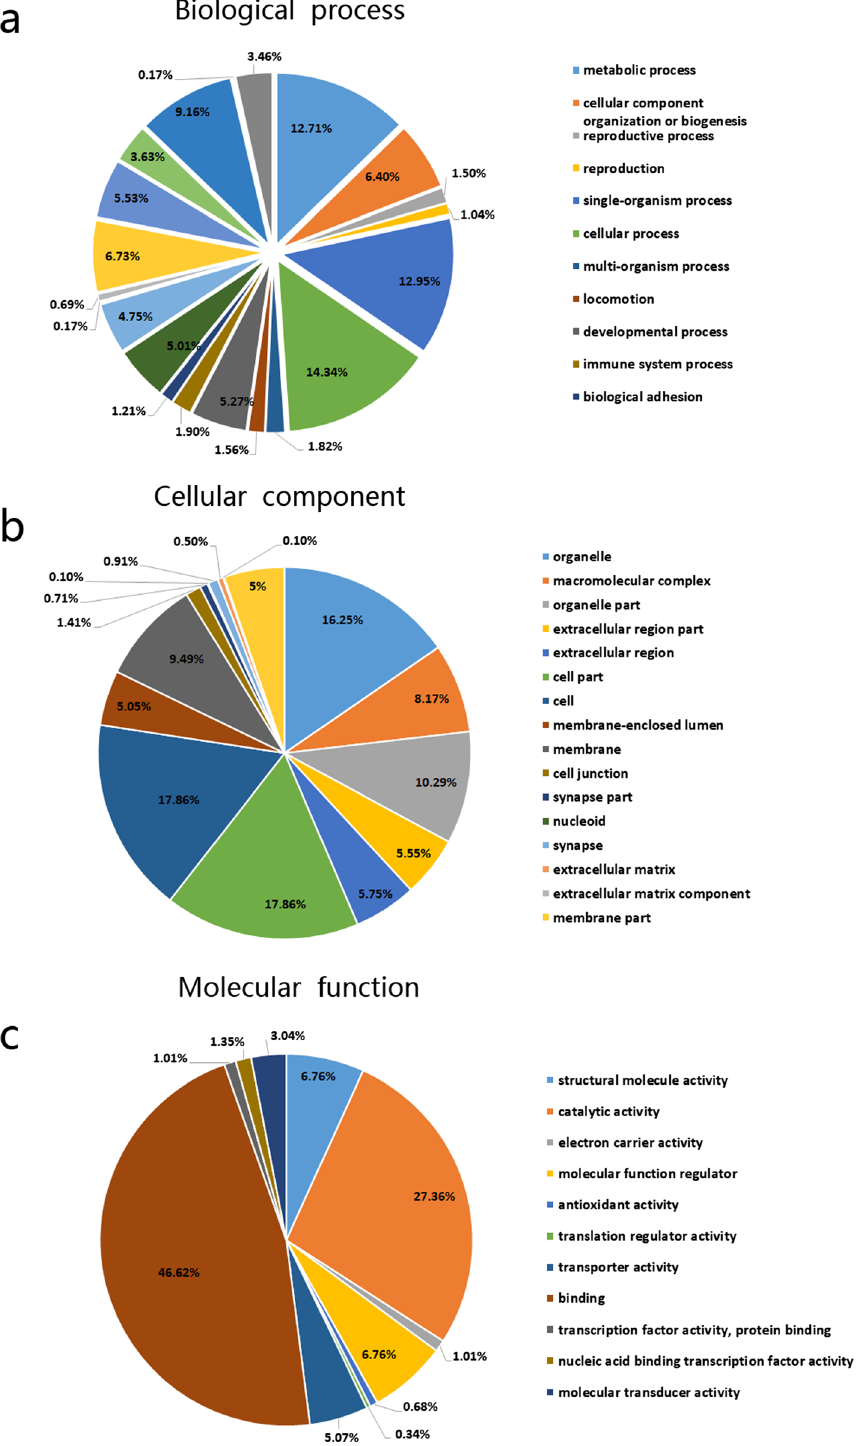
Figure 2. Gene ontology analysis of 195 proteins differentially expressed in BHK cells infected with Eimeria tenella . Proteins were annotated by biological process, cellular component, and molecular